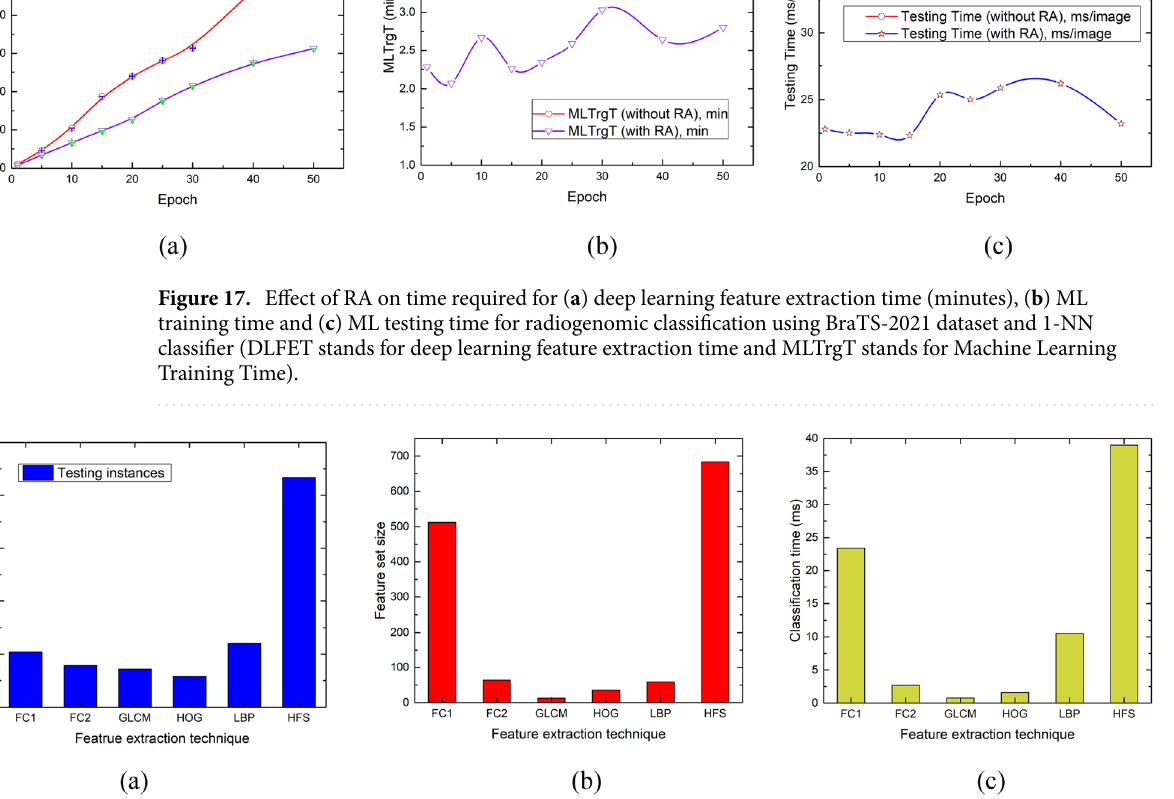
Figure 18. Comparison of ( a ) feature extraction times for potential feature extraction techniques with ( b ) individual feature set size used in the proposed framework, and ( c ) classification time without preprocessing and feature extraction with RA using BraTS-2021 dataset and 1-NN